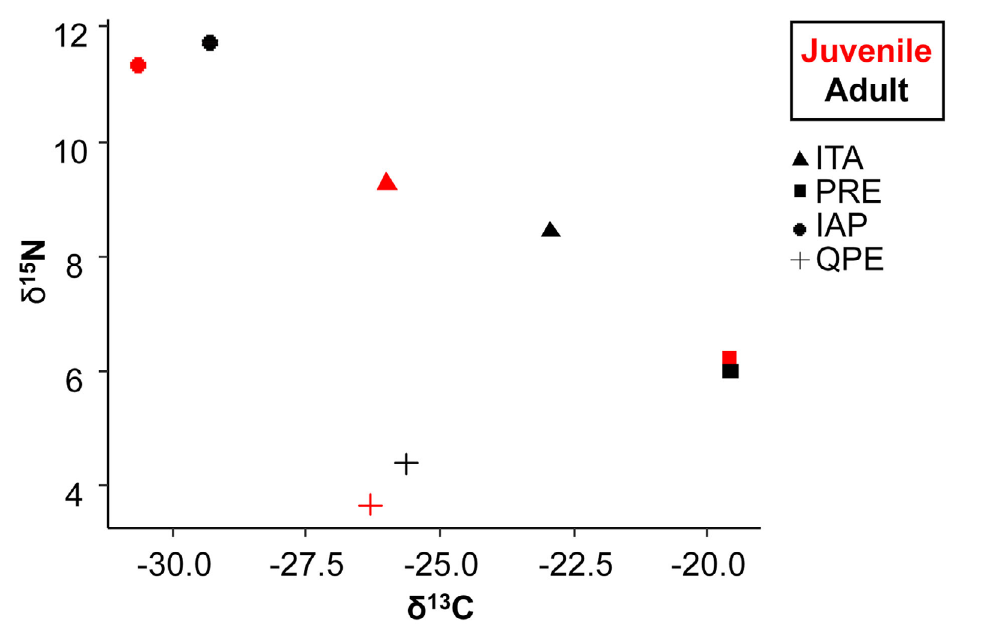
Figure 3. Isotopic biplot of variation in mean δ 13 C and δ 15 N (‰) values calculated for juveniles and adults of Aegla castro at Itatinga from São Paulo State (ITA: Itaúna stream, Paranapanema sub-basin) and Mauá da Serra (PRE: Preto stream, Tibagi sub-basin), Castro (IAP: Iapó stream, Tibagi sub-basin) and Ponta Grossa (QPE: Quebra Perna stream, Tibagi sub-basin) in Paraná